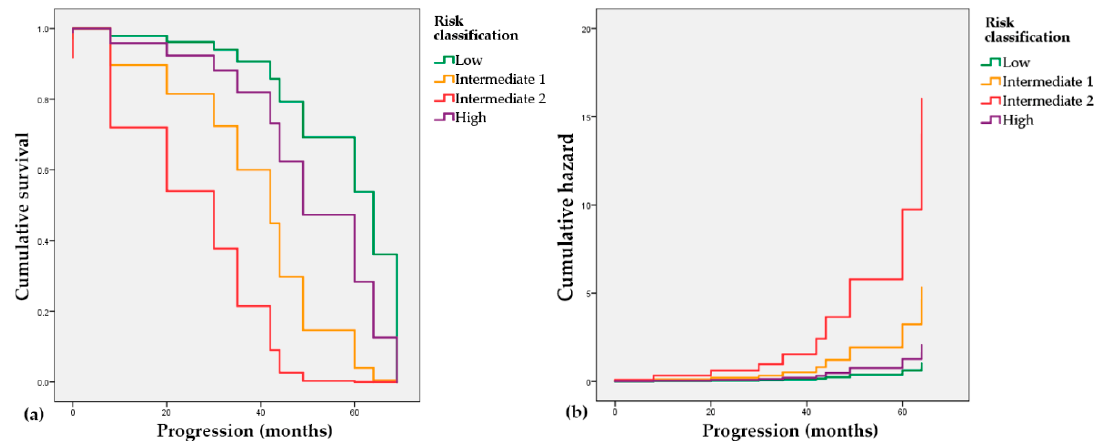
Figure 4. Cox proportional hazards regression. ( a ) Survival probability of patients in the reclassified risk groups; ( b ) Cumulative hazard of progression in the reclassified risk groups.